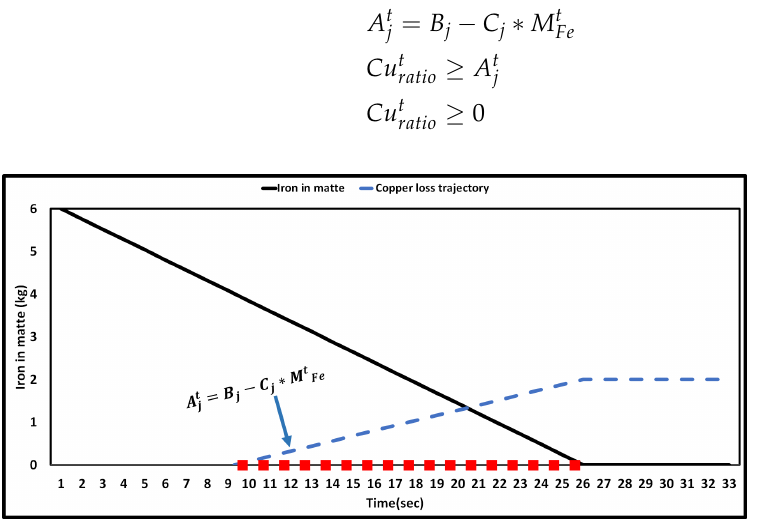
Figure 6. Copper ratio